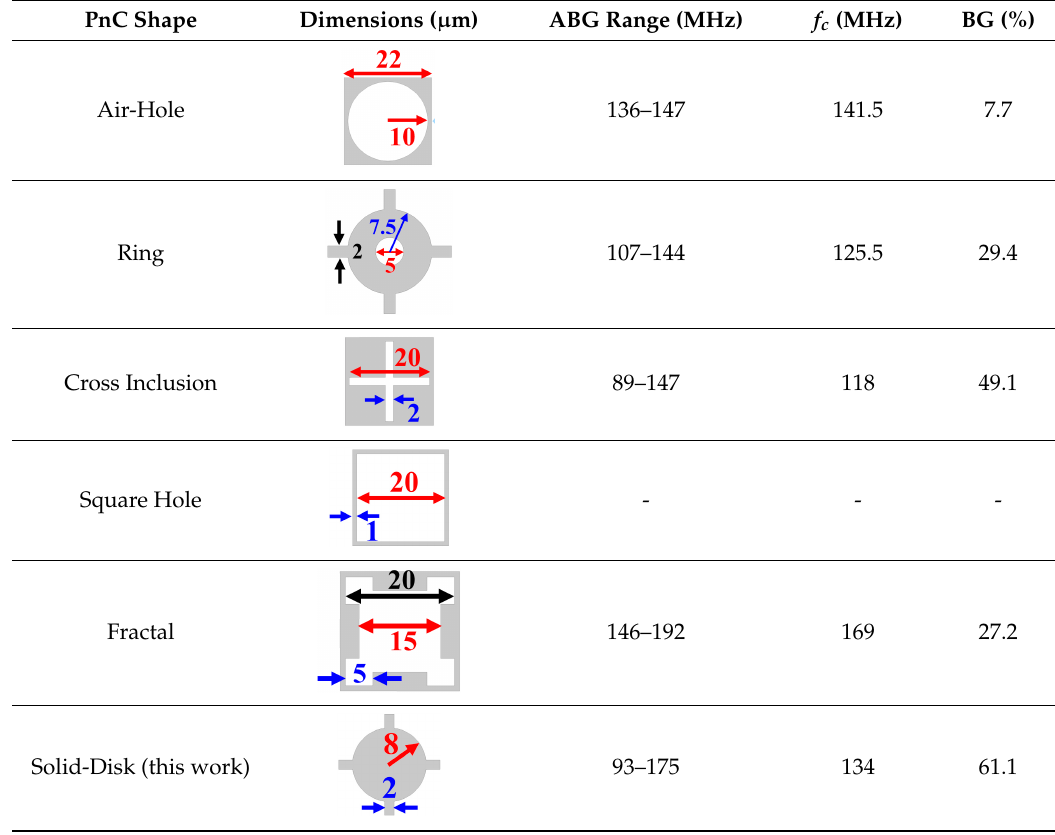
Table 1. Comparison of simulated ABGs between various PnC shapes using the same lattice parameter a = 22 µ m and minimum feature size of 2 µ m.